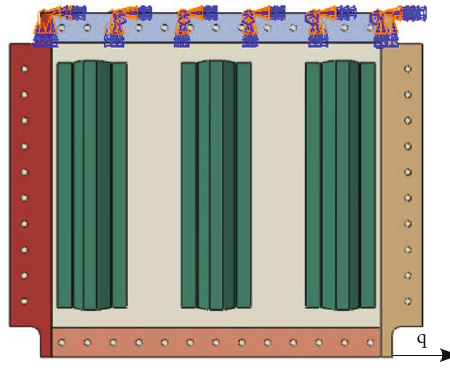
Figure 6: Long side sheared